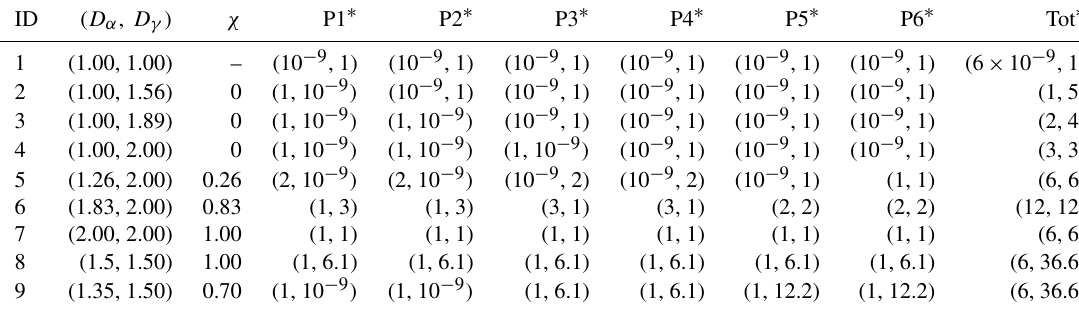
Table 1. Detailed information of the BC particles shown in Fig. 2.